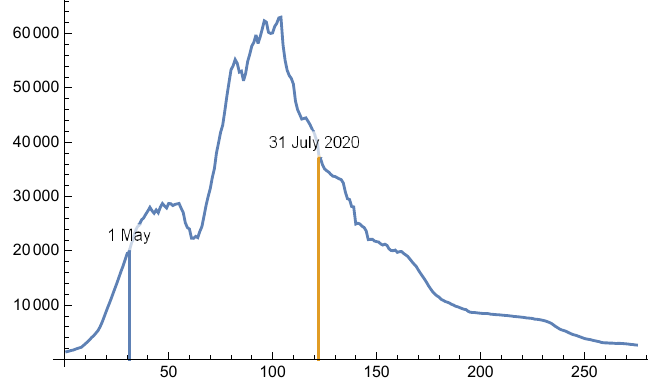
Figure 2. Total daily infected active cases from the first of April to the end of